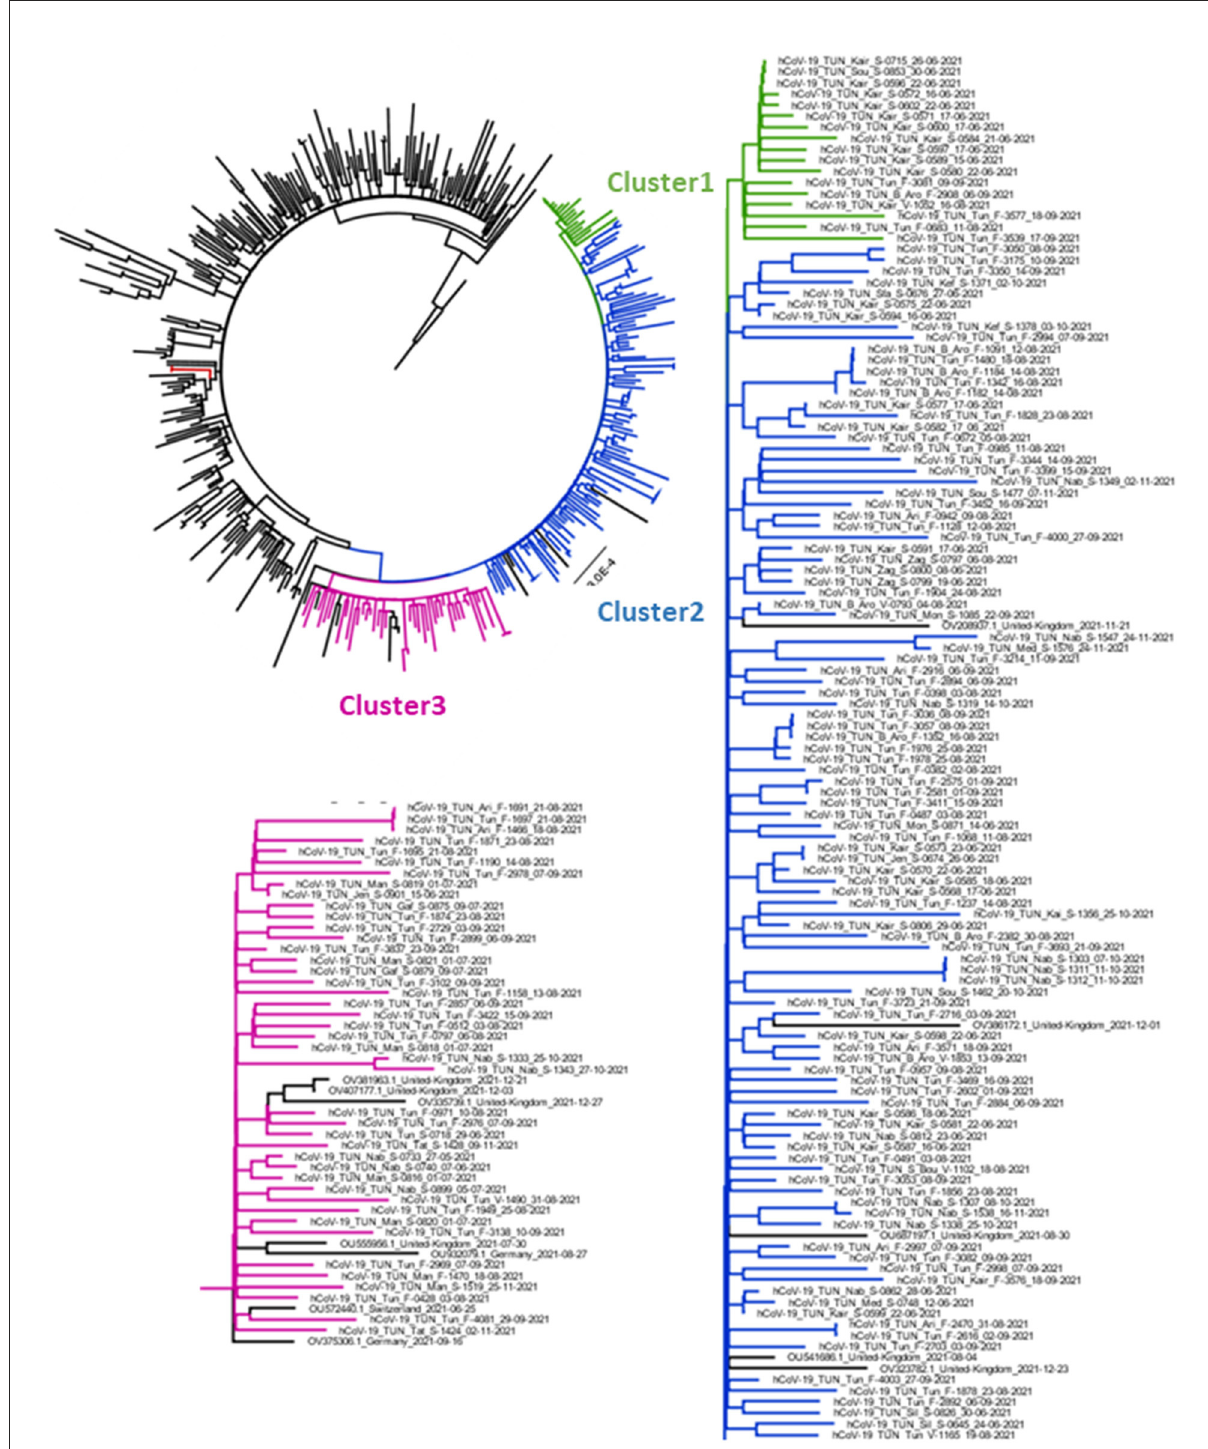
FIGURE5 Phylogenetic analysis of AY.122 sub-lineage’s Delta strains obtained in Tunisia between May and December. The Maximum Likelihood tree was obtained by comparison of 391 High quality AY.122 genomes obtained from Tunisia and other regions of the word. Tunisian sequences are indicated in Green (Cluster1), Blue (Cluster 2) and Pink (Cluster3) and other sequences different the world in Black. The tree was generated by IqTree software with 1000 boostrap cycles and visualized by FigTree